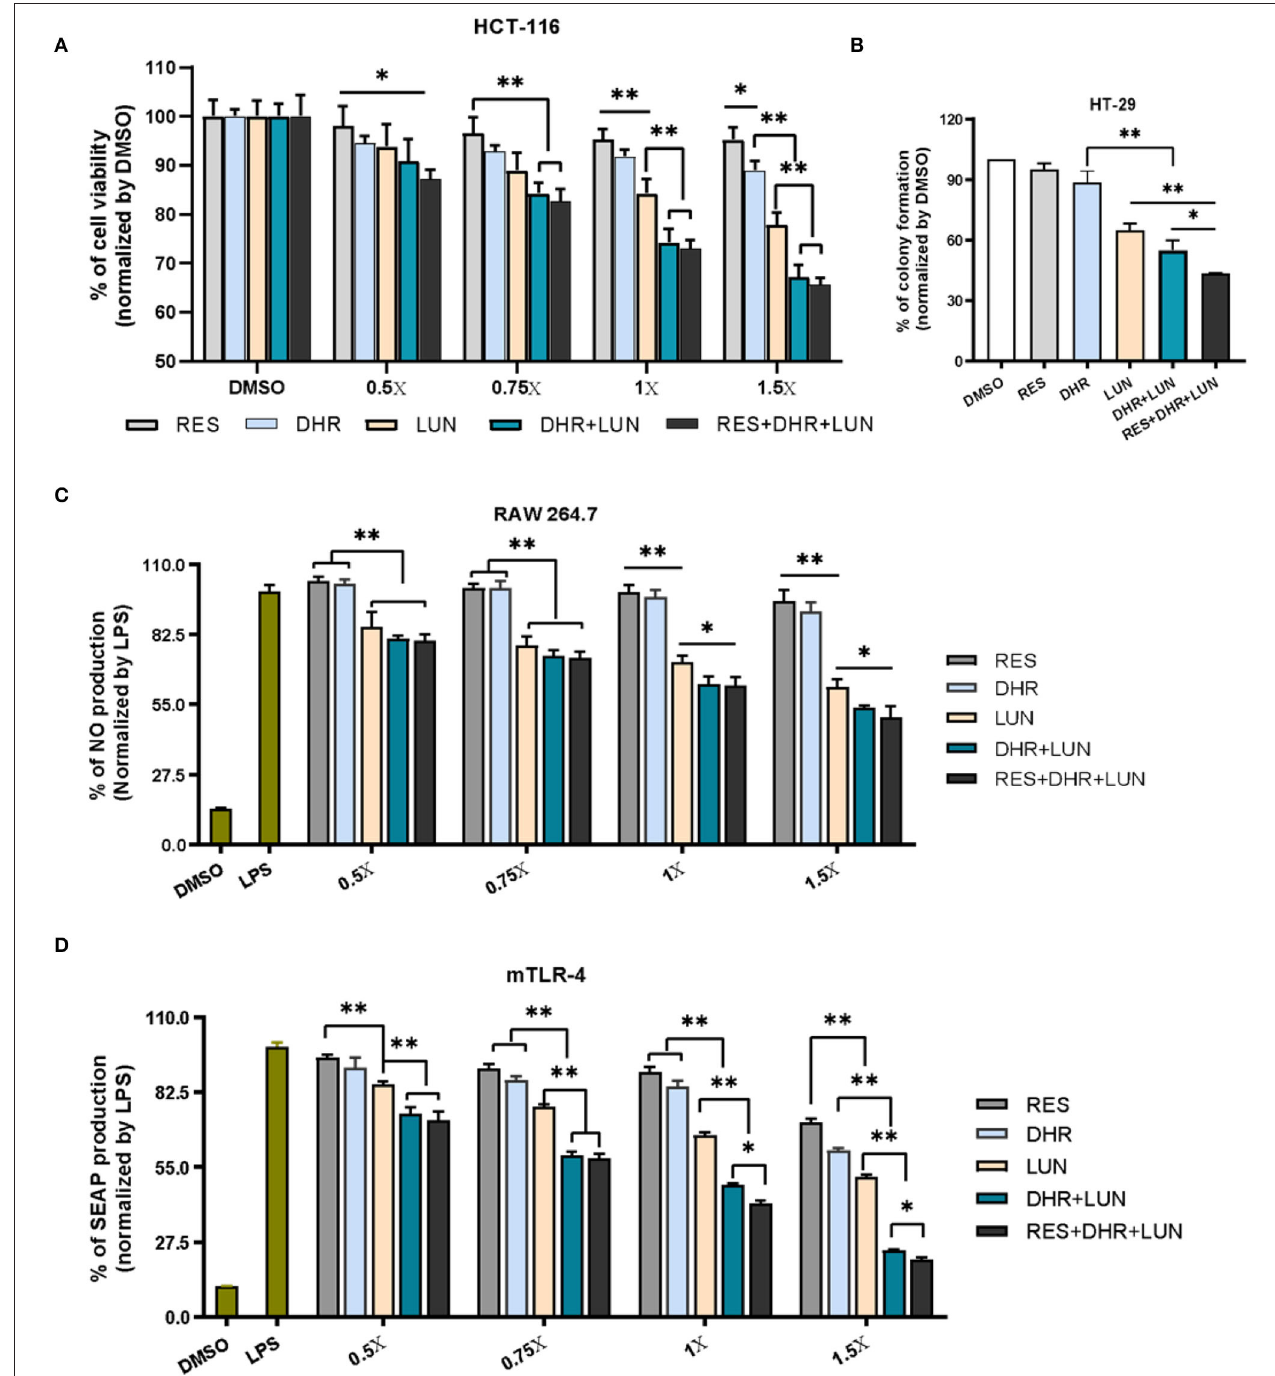
FIGURE 7 | Anti-proliferative, anti-clonogenic, and anti-inflammatory effects of RES, DHR, and LUN at the colonic tissue levels. Anti-proliferative effects of RES, DHR, and LUN on HCT-116 cancer cell line (A) . Anti-clonogenic effects of RES, DHR, and LUN on HT-29 cancer cell line (B) . The inhibition of RES, DHR, and LUN on NO production in LPS-stimulated RAW264.7 macrophages (C) . Inhibitory effects of DHR, LUN, and their combination on LPS-induced SEAP production in HEK TM mTLR-4 cells (D) . Three independent experiments were conducted. Data presented as mean ± SEM. Significant differences are indicated: * P < 0.05, ** P < 0.01.